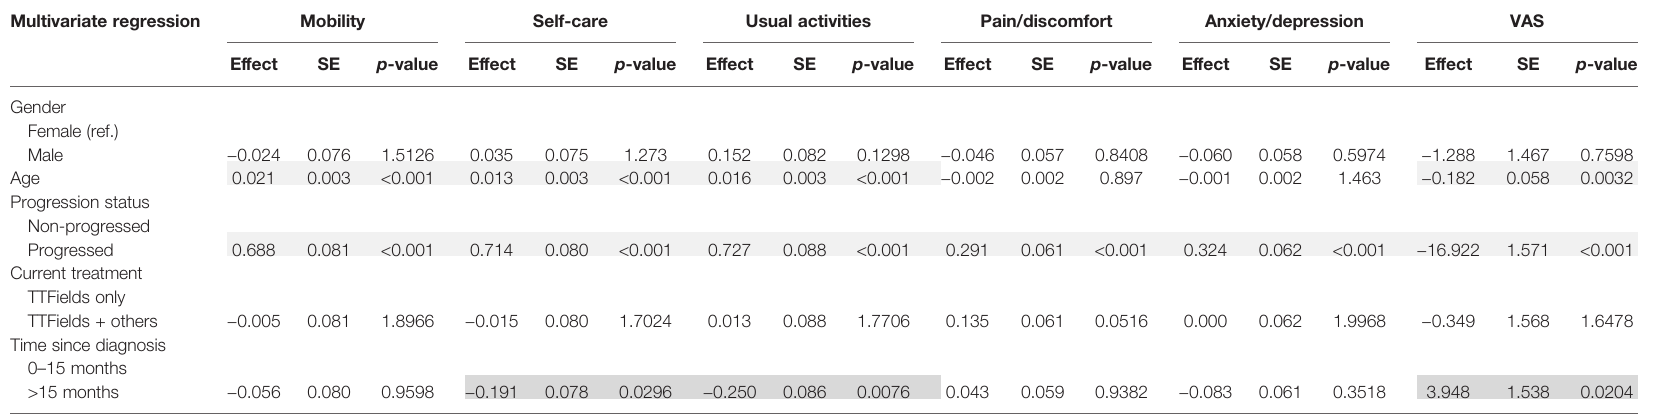
TABLE 4 | Multivariate regression results with time since diagnosis. Multivariate regression Mobility